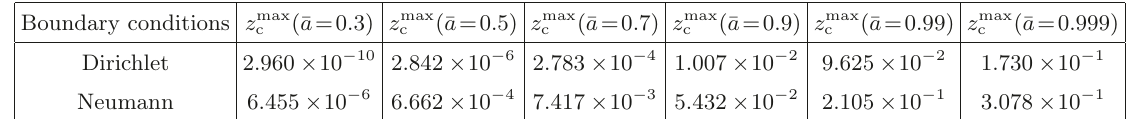
Table 1 . Marginally-stable spinning exotic compact objects. We display, for various values of the dimensionless angular momentum parameter ¯ a , the largest dimensionless radii z max r + ) /r + (see eqs. (4.1) and (4.2)) of the horizonless reflecting compact objects that can support the spatially regular static scalar field configurations with l = m = 1. One finds that the critical radii { z max (¯ a ) } , which characterize the marginally-stable spinning exotic compact objects, are a c monotonically increasing function of the dimensionless angular momentum parameter ¯ a